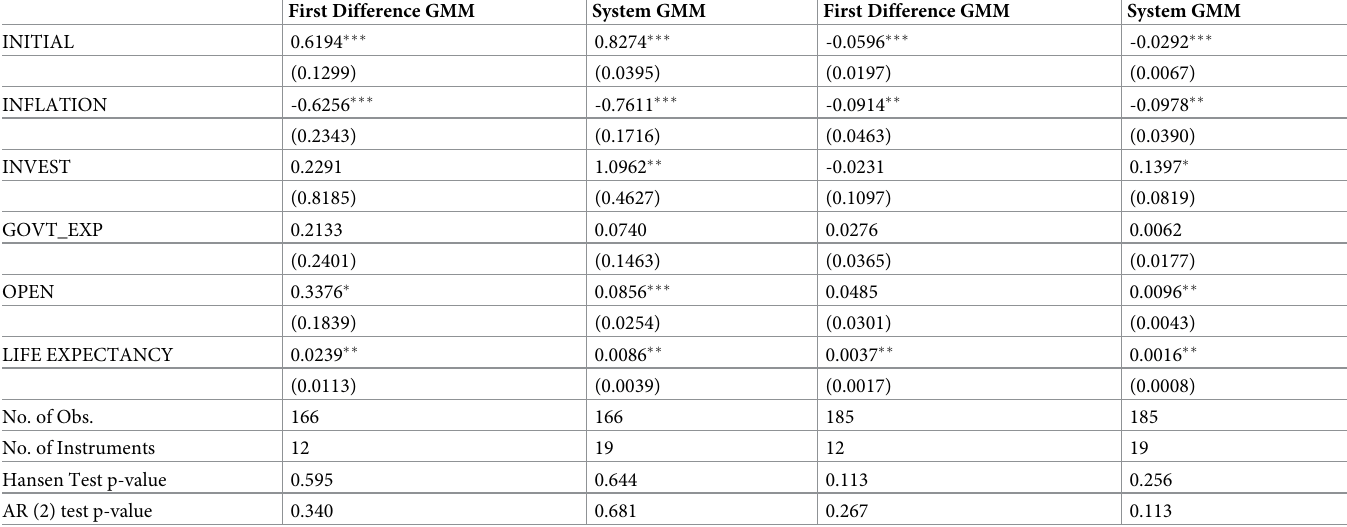
Table 7. Panel GMM results excluding